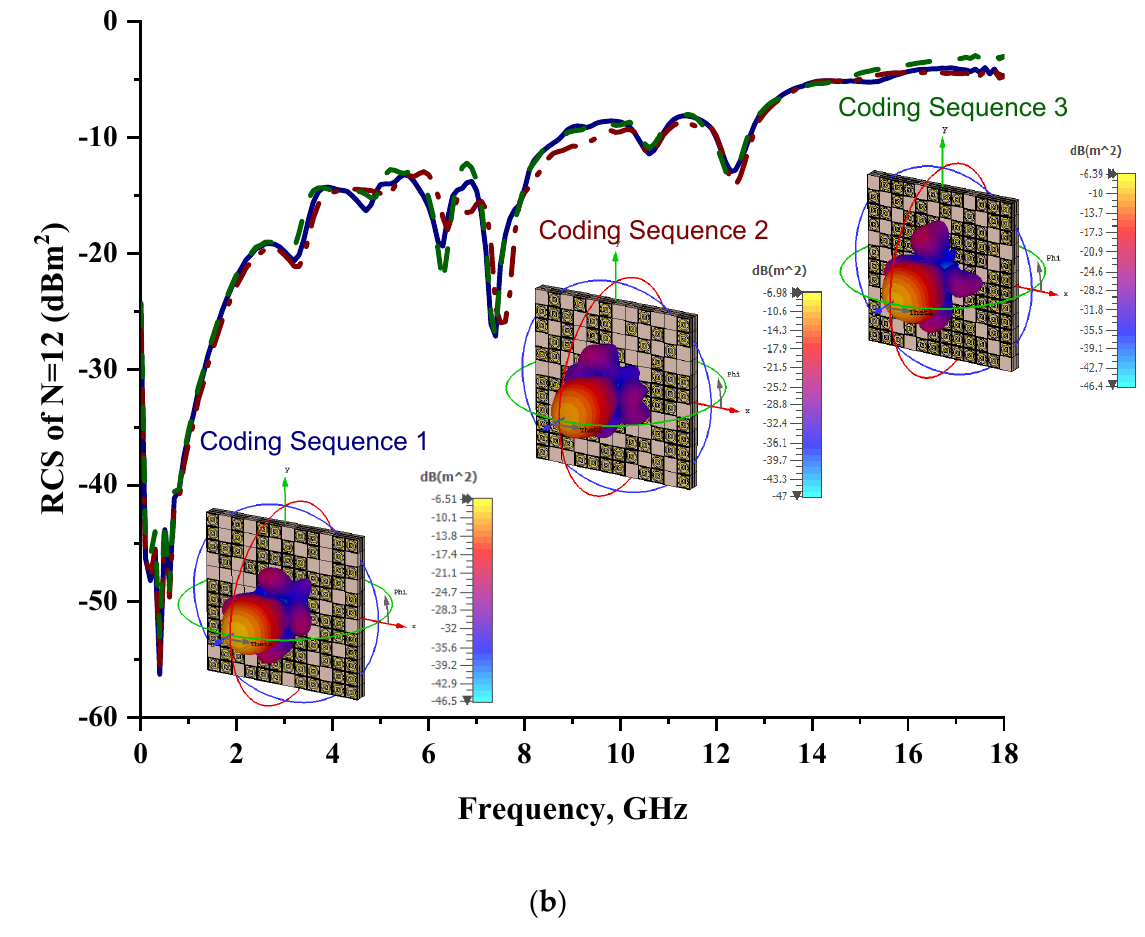
Figure 12. Monostatic RCS values and bistatic RCS values at 8 GHz for one-bit coding metamaterials with ( a ) double layers and ( b ) triple layers.